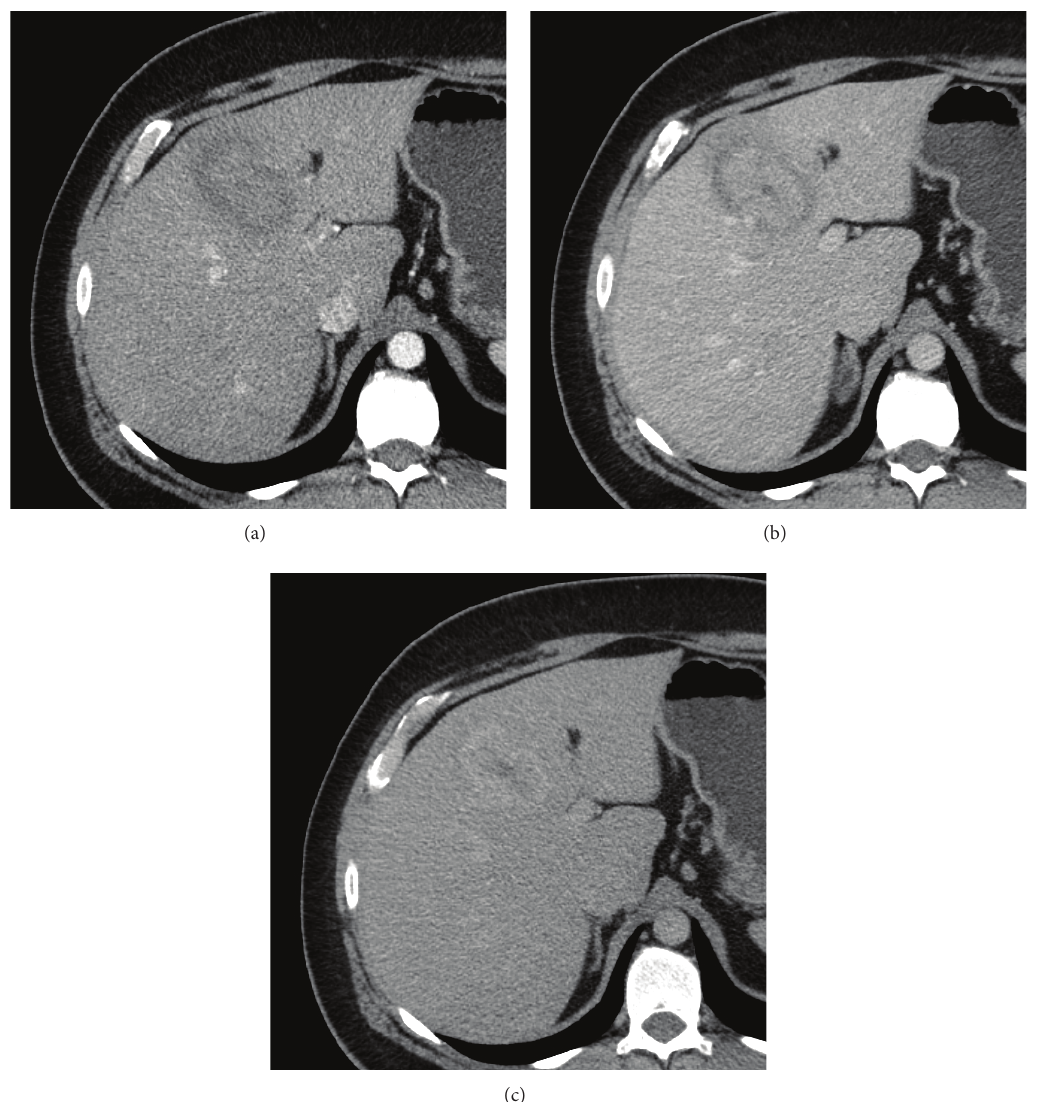
Figure 1: Abdominal contrast-enhanced CT. (a) and (b) Scans on arterial and portal phases show a target-like lesion in the segment IV of the liver. The lesion and the normal hepatic parenchyma enhance likewise; a hypoattenuating rim and a tiny hypoattenuating core are also evident. (c) The rim strongly enhances on late venous phase